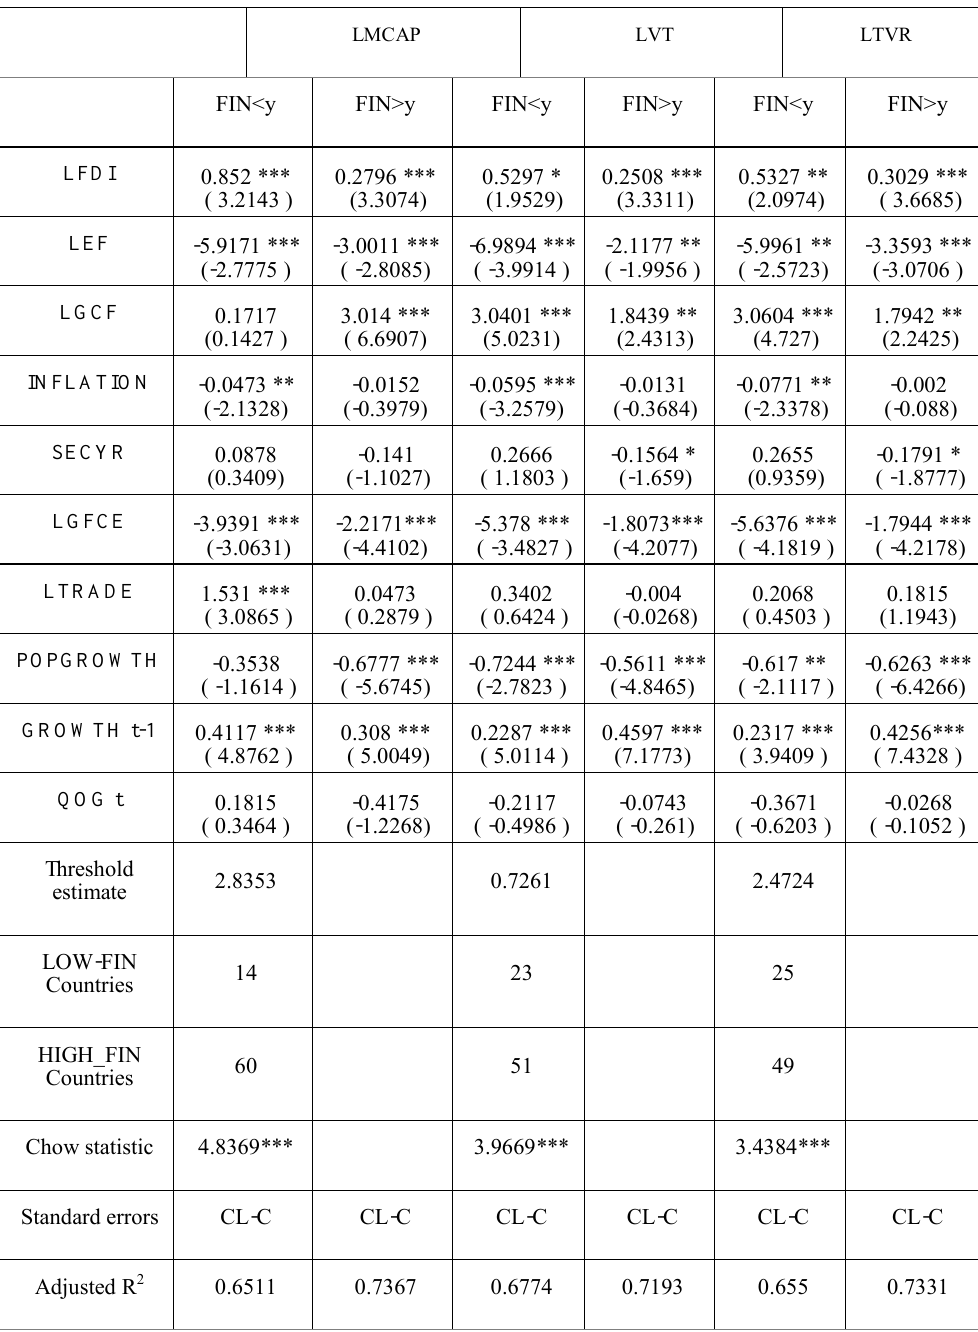
Table9. threshold regression with stock market indicators as threshold